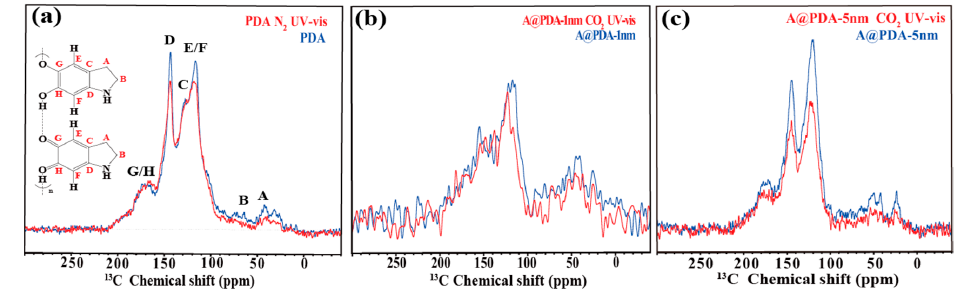
Figure 4. 13 C cross-polarization total suppression of spinning sidebands (CP-TOSS) spectrum of: pristine PDA and PDA after illuminating under UV-vis light in the presence of N 2 for 11 h ( a ); pristine A@PDA-1 nm and A@PDA-1 nm after illuminating in CO 2 for 11 h ( b ); and pristine A@PDA-5 nm and